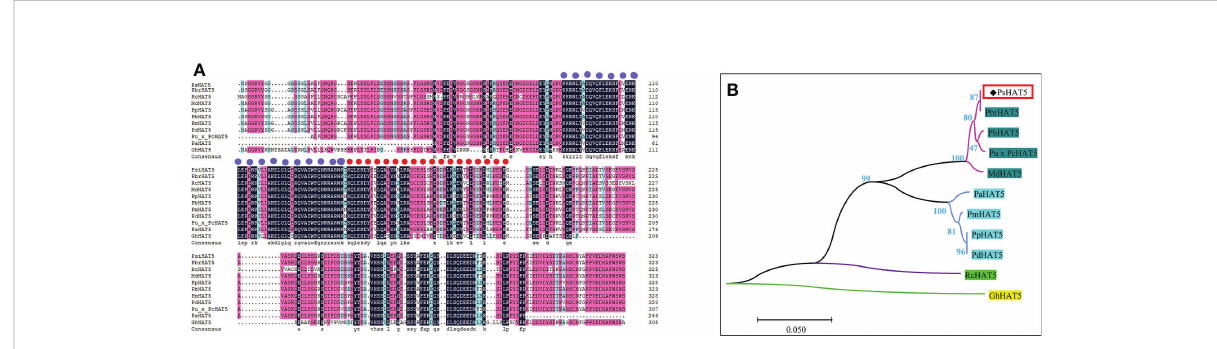
FIGURE 1 Homologous sequence alignment and phylogenetic analysis of PsHAT5 transcription factor. (A) Sequence comparison results of PsHAT5 with homologous proteins in other species (The purple circles represent the HD domain, and the red circles represent the LZ domain.). (B)